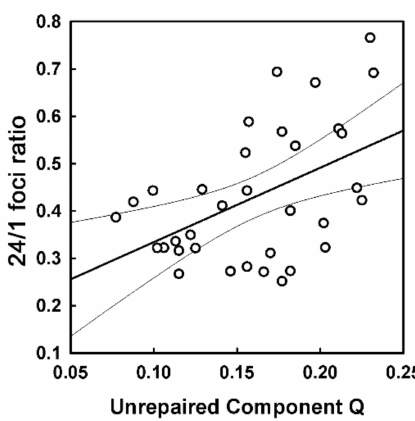
Figure 4. Correlation between Q -values and the ratio of background foci in PBMC collected at 24 and 1 h post first radiotherapy (RT) session. The 24 / 1 h ratios for all patients are presented in Table S2. This ratio reflects the e ffi ciency of in vivo repair of DNA damage induced in PBMC by RT treatment. 2.3. Correlation Studies with Treatment Conditions; PBMC that Were not Exposed to Ex Vivo Irradiation